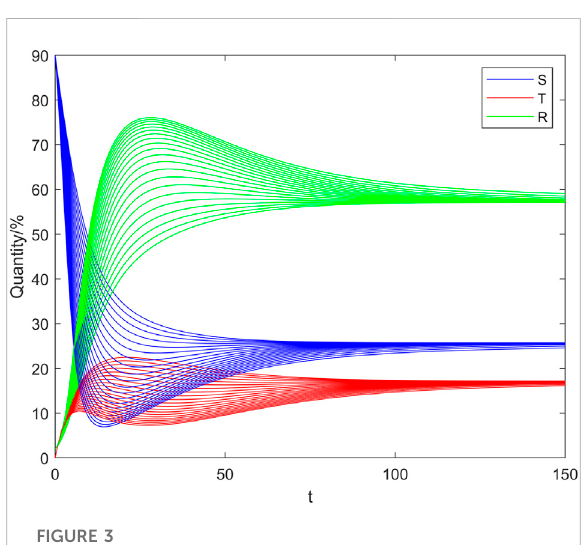
FIGURE 3 Variations in the numbers of S , T , R when R 0 <